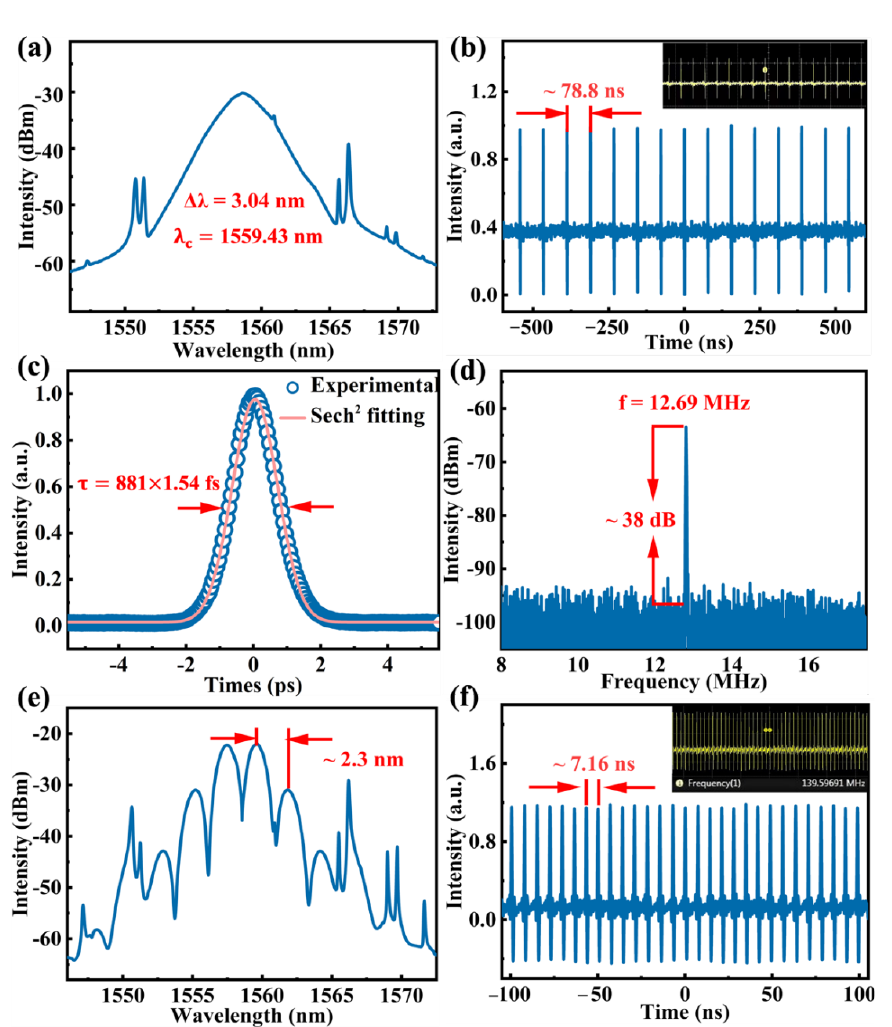
Figure 7. Typical mode-locked pulse output characteristics of the EDF laser based on 2D Bp/InSe SA. ( a ) Optical spectrum. ( b ) Pulse train. ( c ) Autocorrelation trace. ( d ) Radiofrequency (RF) spectrum. The 11th harmonic mode locking of bound state output characteristics of the EDF laser based on 2D Bp/InSe SA. ( e ) Optical spectrum. ( f ) Pulse train.